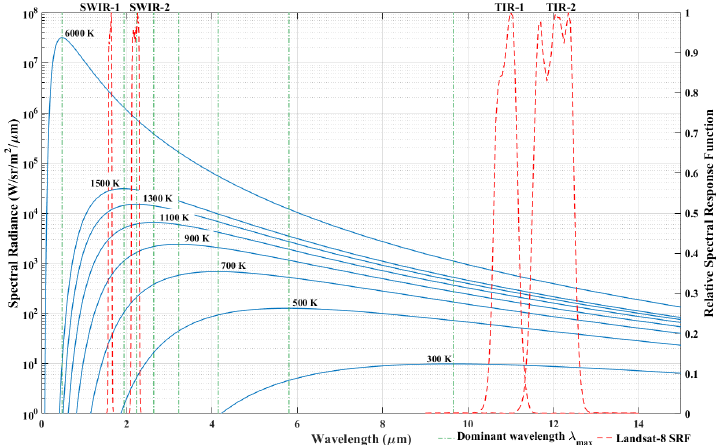
Figure 1. Blackbody radiation curves at different blackbody temperatures, as derived from Plank’s law, and relative spectral response functions of the Landsat-8 operational land imager (OLI) and thermal infrared sensor (TIRS).